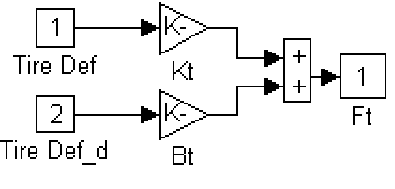
Figure A4. Tire module.